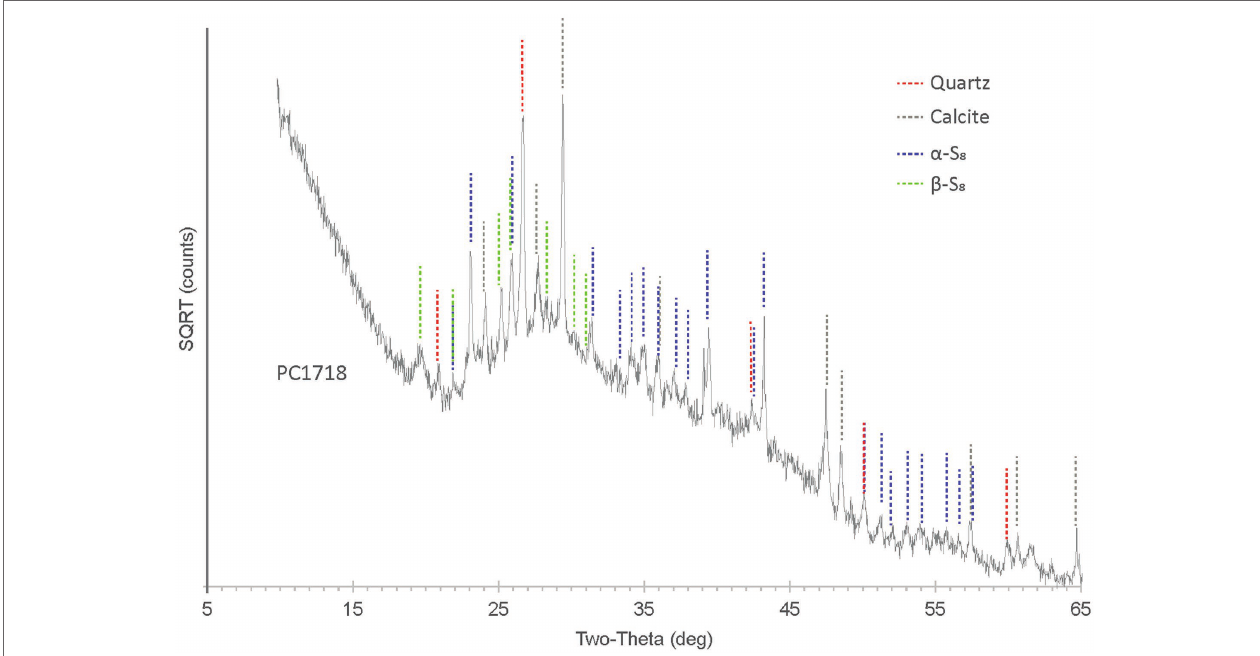
FIGURE 4 | XRD spectrum for biofilm sample PC1718. The peaks in the diffractogram include matches for α -S 8 , β -S 8 , quartz, and